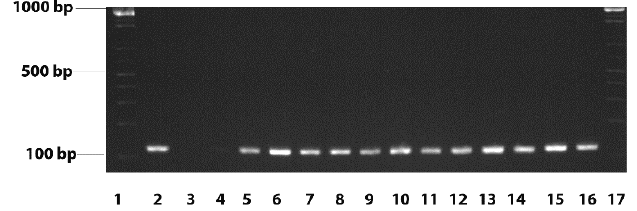
Figure 1. Representative PCR results of the amplification of the agaC gene of the D. congolensis isolates. Lanes 1 and 17—Molecular weight markers; Lane 2—positive control ( D. congolensis ATCC: 14637); Lane 3—negative controls (no template DNA); Lane 4—negative control (no Taq polymerase) Lanes 5–16— D. congolensis isolates.